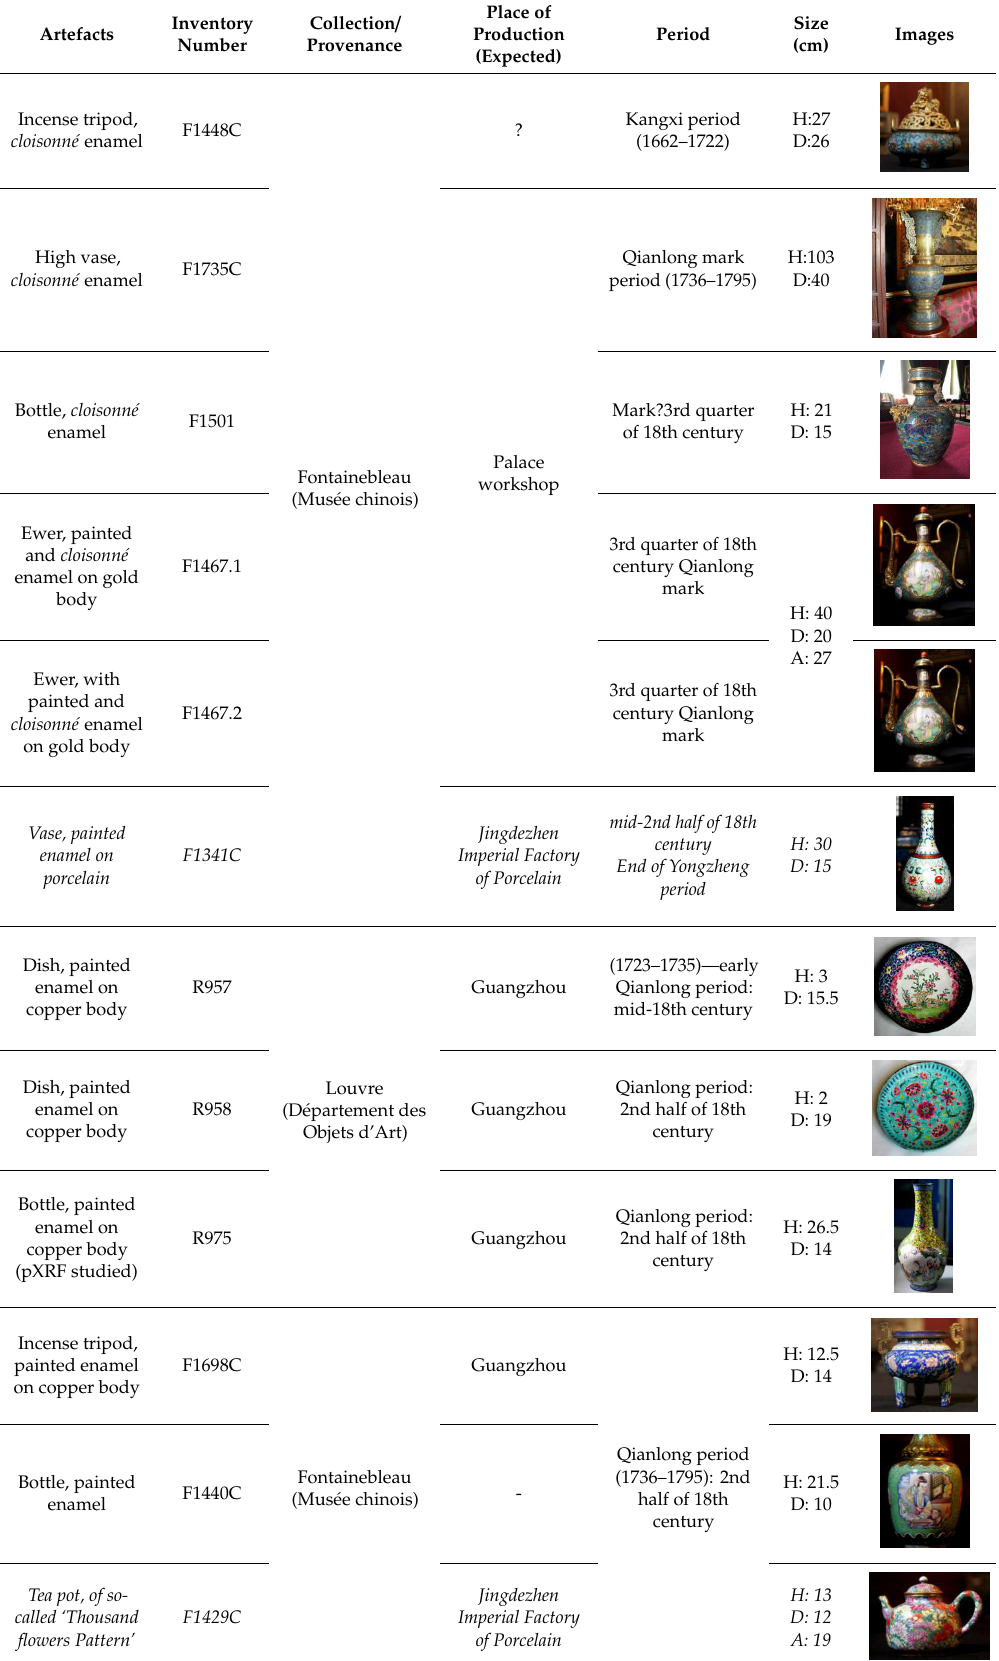
Table 1. The artefacts with painted and / or cloisonn é enamels (H: height; D: diameter). Table 1. The artefacts with painted and/or cloisonné enamels (H: height; D: diameter). Table 1. The artefacts with painted and/or cloisonné enamels (H: height; D: diameter). Table 1. The artefacts with painted and/or cloisonné enamels (H: height; D: diameter). Table 1. The artefacts with painted and/or cloisonné enamels (H: height; D: diameter). Table 1. The artefacts with painted and/or cloisonné enamels (H: height; D: diameter). Table 1. The artefacts with painted and/or cloisonné enamels (H: height; D: diameter). Table 1. The artefacts with painted and/or cloisonné enamels (H: height; D: diameter). Table 1. The artefacts with painted and/or cloisonné enamels (H: height; D: diameter). Table 1. The artefacts with painted and/or cloisonné enamels (H: height; D: diameter). Place of Place of Inventory Inventory Inventory Collection/ Size Inventory Collection/ Inventory Collection/ Inventory Collection/ Inventory Inventory Artefacts Artefacts Artefacts Artefacts Production Period Images Artefacts Production Artefacts Artefacts Artefacts Artefacts Artefacts Number Number Number Provenance (cm) Number Provenance Number Provenance Number Provenance Number Number (Expected)